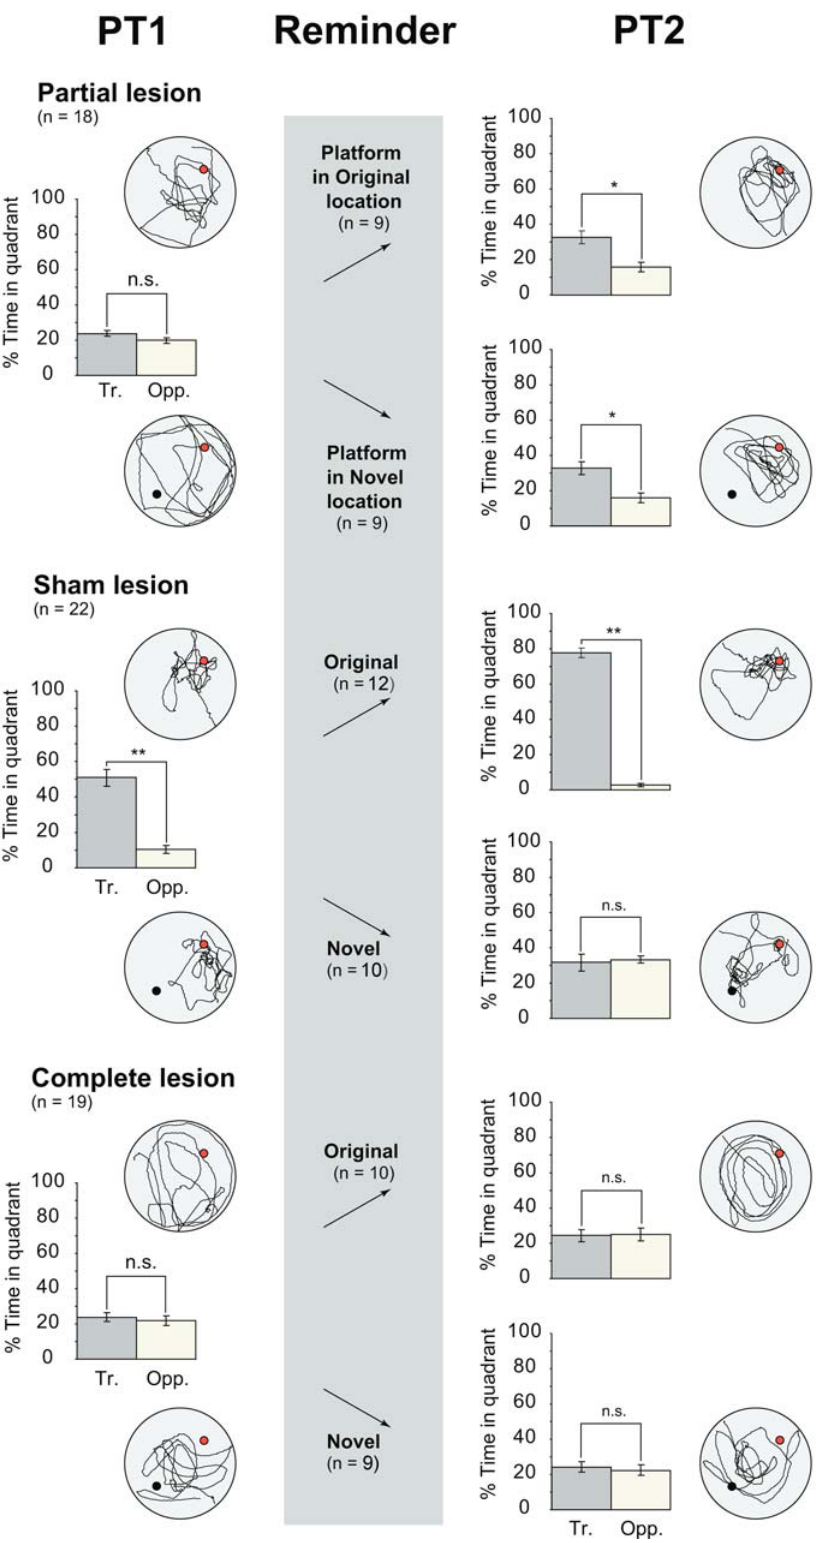
detectable in the sham lesion group ( t = 4.18, df = 21, p , 0.005, one-sample t-test, comparison with chance = 50%), but not in the two lesion groups. PT1 ended with the animals finding the platform in the